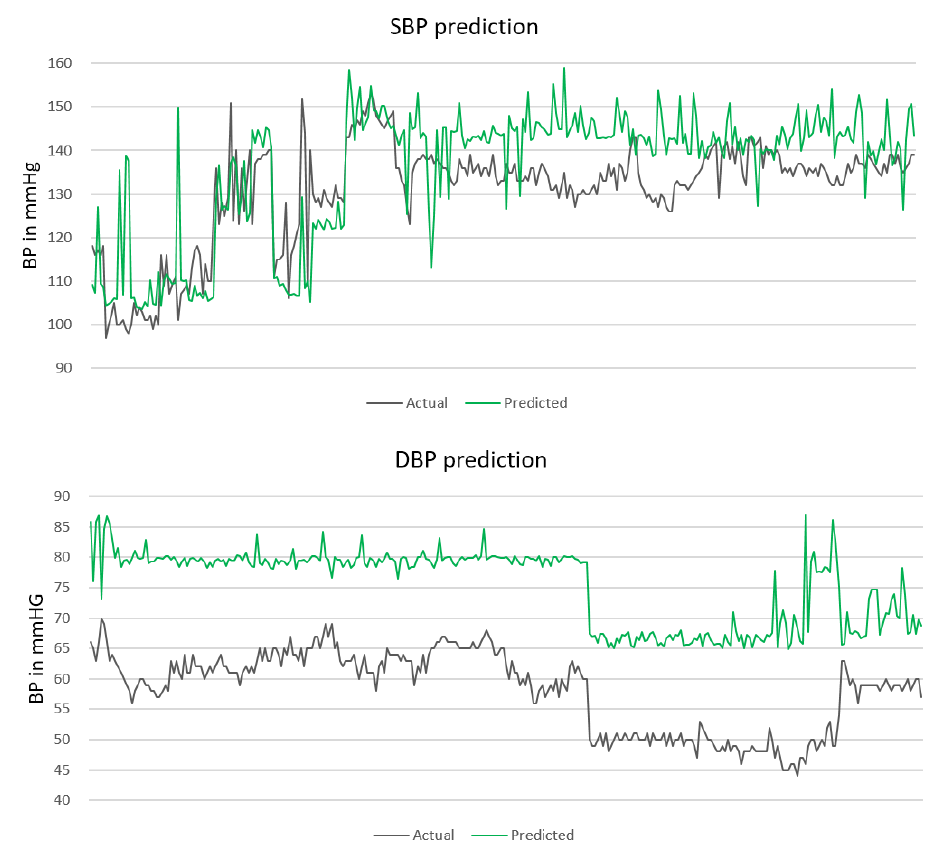
Figure 2. SBP and DBP prediction for testing